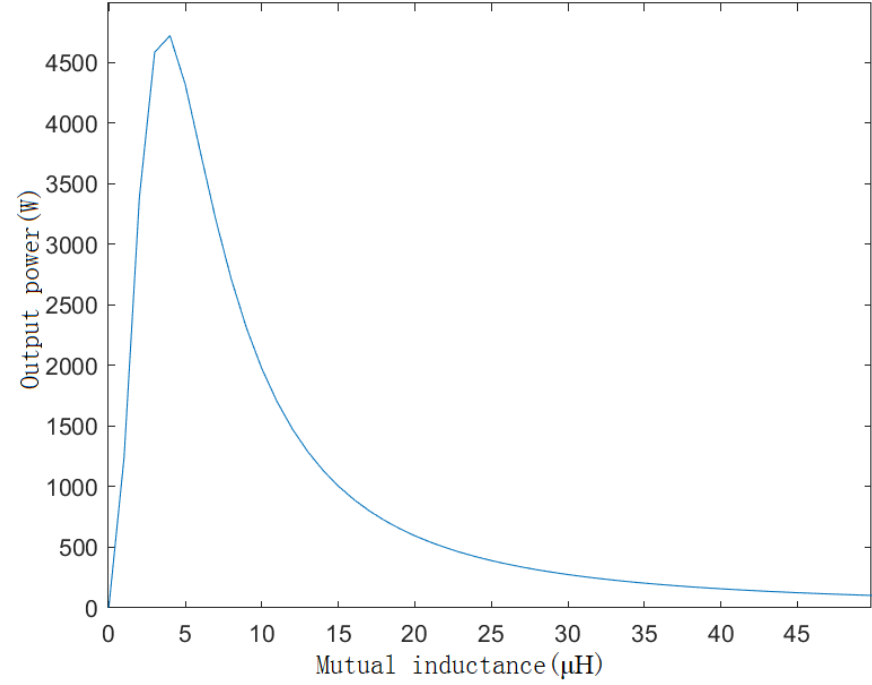
Figure 4. Relationship between output power and mutual inductance.